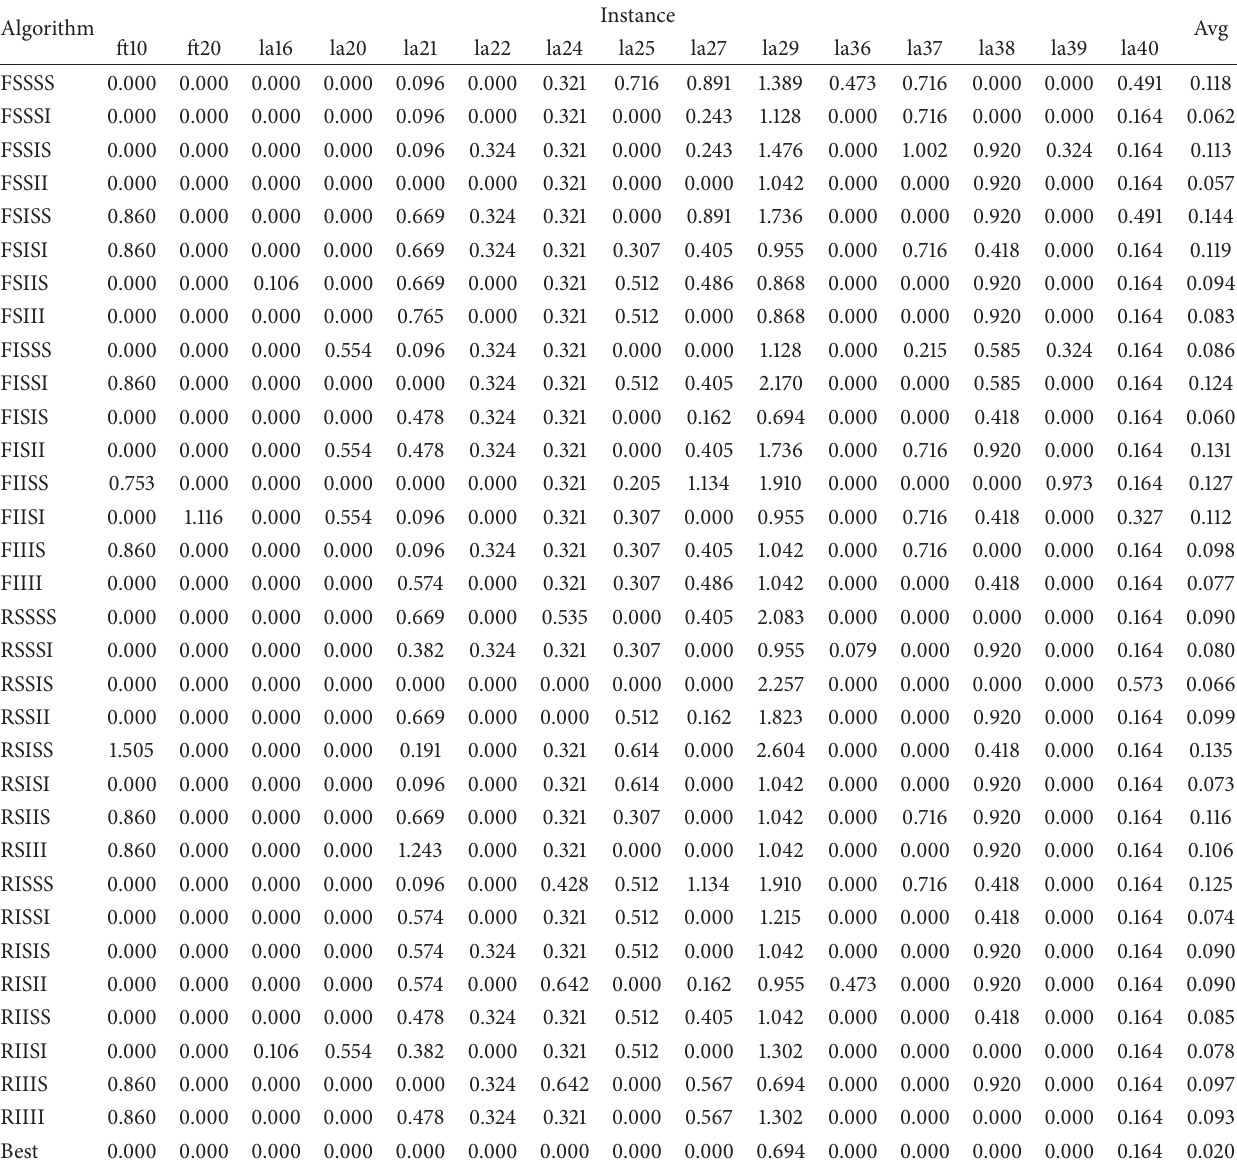
Table 1: Solution value deviations (%) of 16 FVNS and 16 RVNS